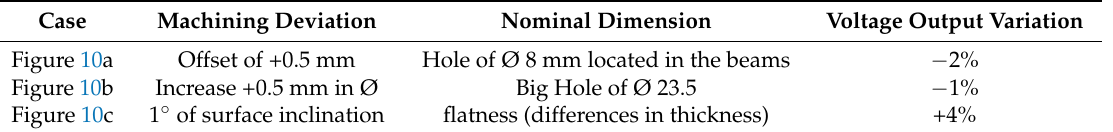
Figure 10. Strain variation in accordance with tolerance: ( a ) Location, ( b ) Size, and ( c ) Flatness. A comparison of the theoretical voltage output of the Wheatstone bridge with the ideal design is shown in Table 4. In conclusion, the relation voltage/torque may slightly change the offset and/or the slope, but they keep very good linearity, corroborating the good properties of the selected material. Table 4. Voltage variation in accordance with manufacturing deviation.